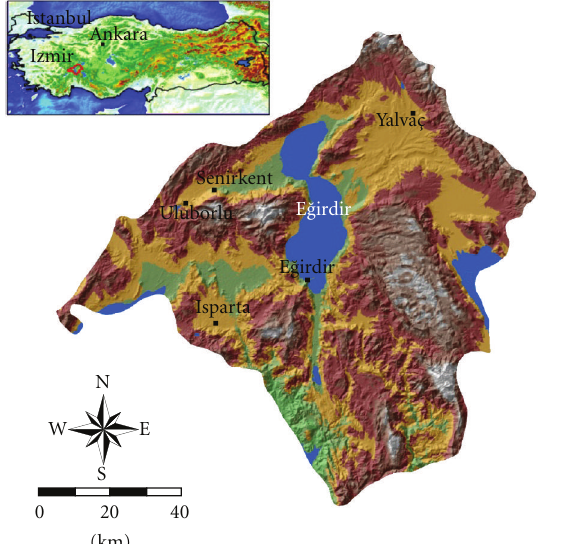
Figure 2: Locations of rain gauges in